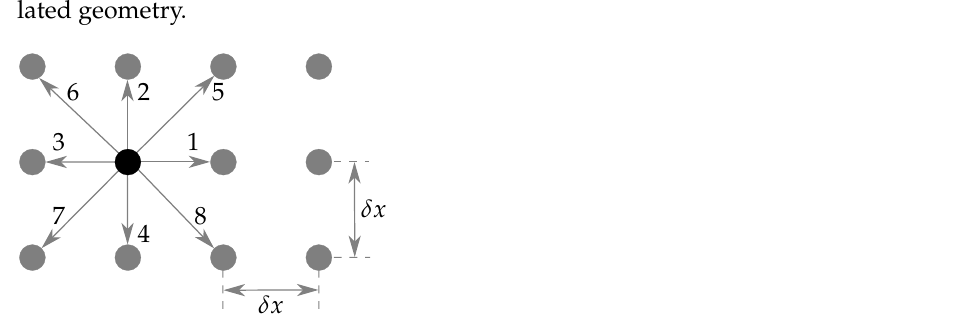
Figure 1. D2Q9 lattice arrangement and indices of lattice links (index 0 denotes the node itself). Circles denote lattice